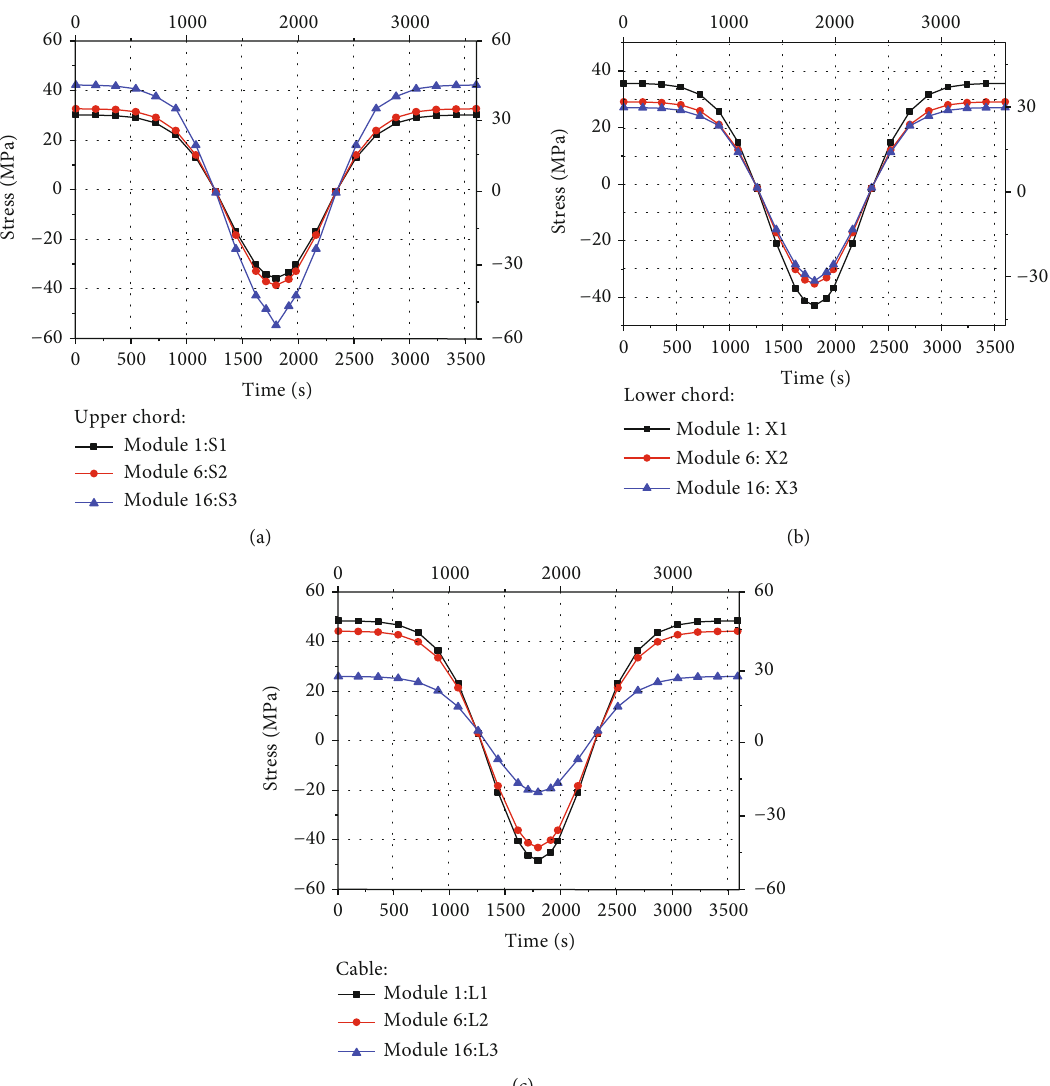
Figure 8: Thermal stress distribution of the rods in di ff erent modules. (a) Upper chord. (b) Lower chord. (c)